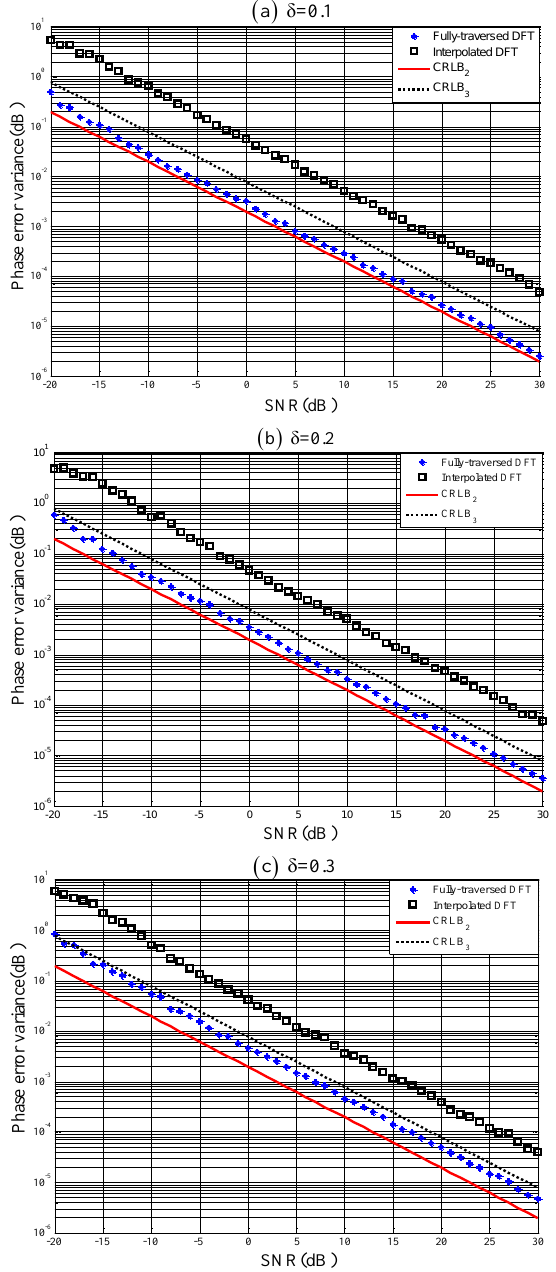
Figure 2. Error variances of the phase estimator with ( a ) δ = 0.1, ( b ) δ = 0.2 and ( c ) δ = 0.3.